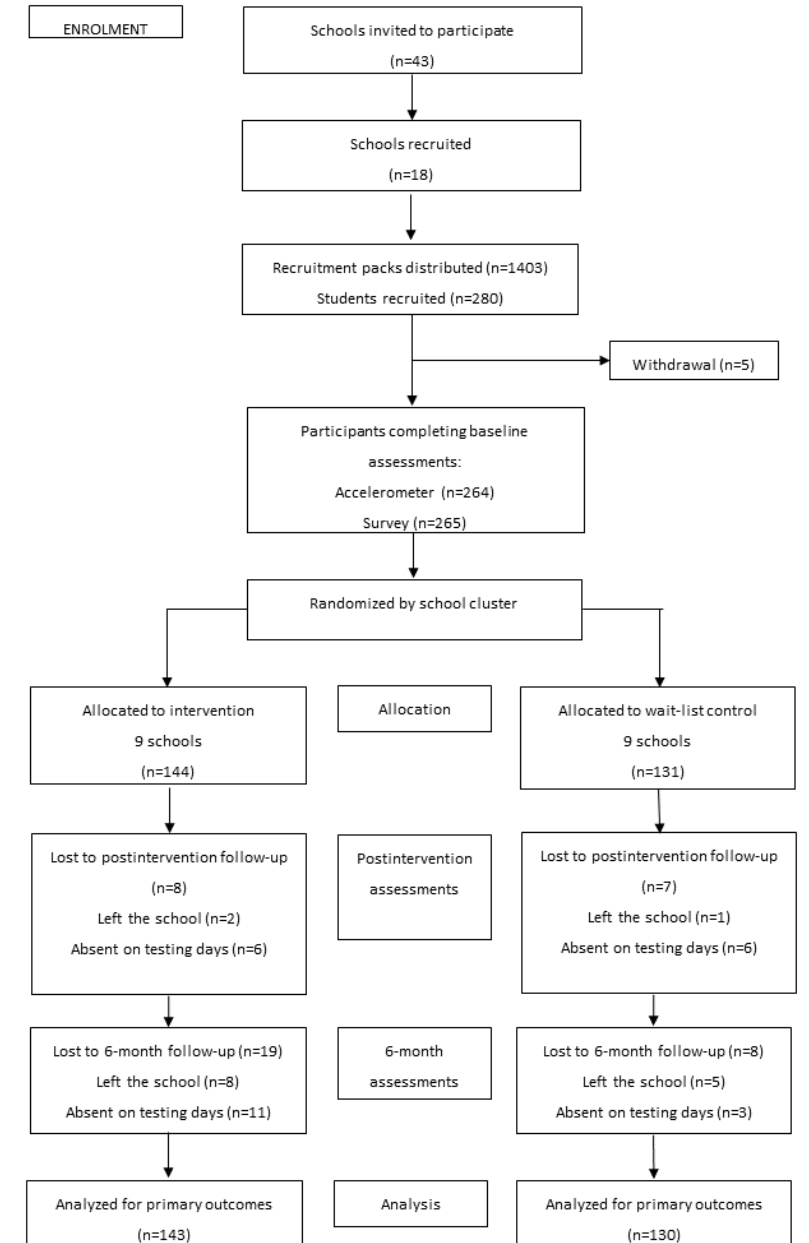
Figure 1. Flow of participants throughout the study. This study focused on the data collected at